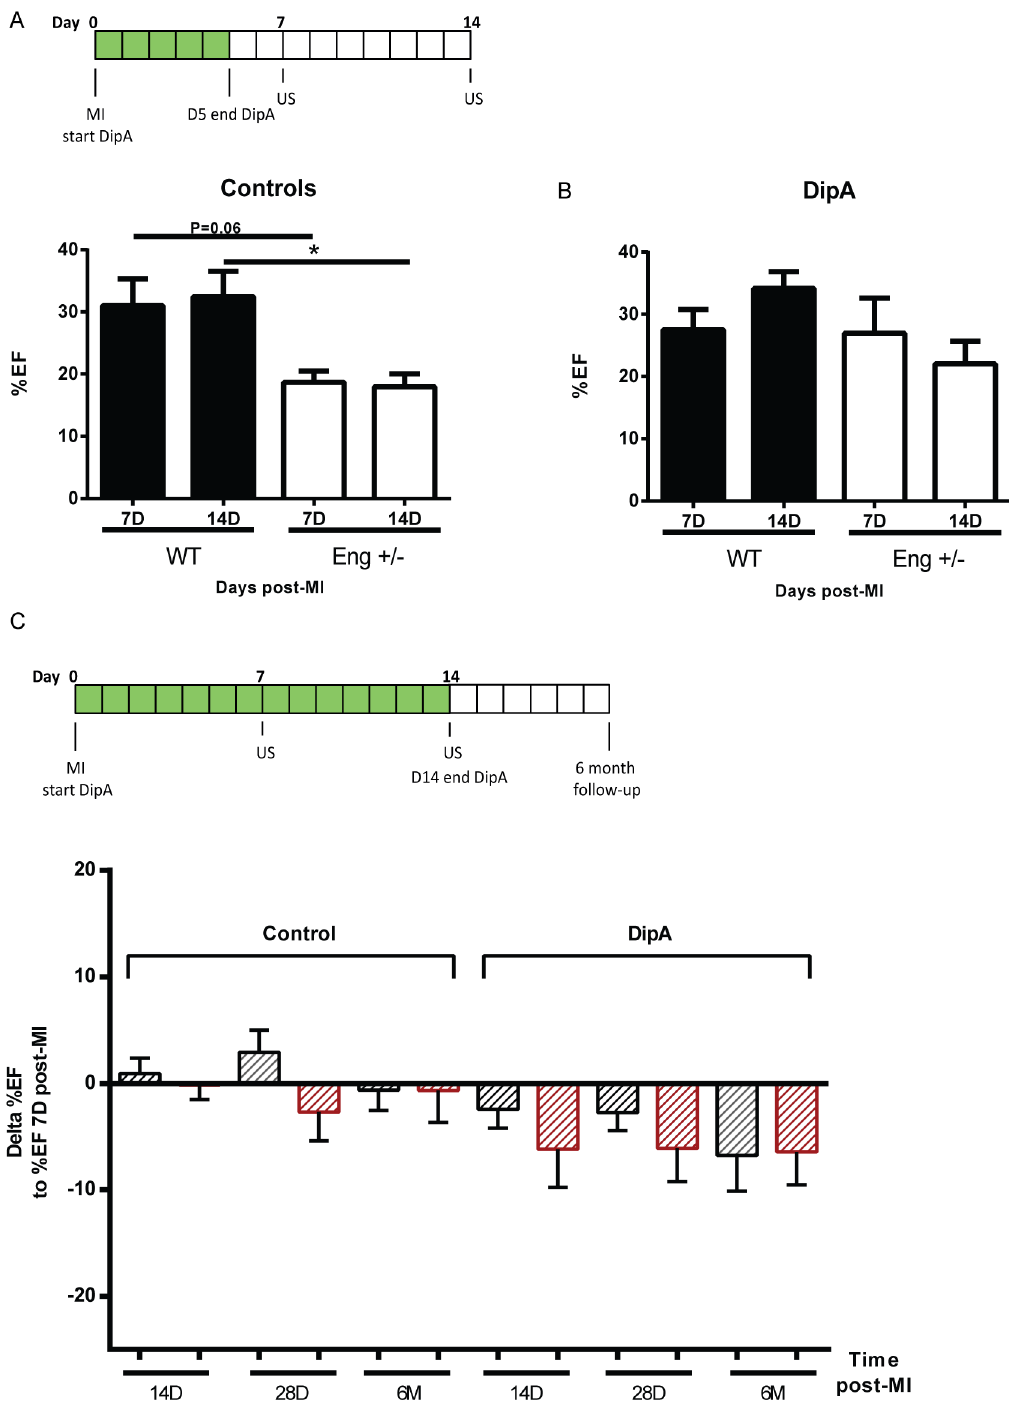
Fig 4. DipA treatment does not maintain improved cardiac function of Eng +/- mice after MI. (A) Experimental overviewand percentage EF at 7 and 14 days post-MI of control treated mice, measuredby ultrasound via left ventricletracing (n = 5–9). Data shown are mean ± SEM, * P < 0.05. (B) PercentageEF 7 and 14 days post-MI of DipA treated mice, measuredby ultrasound via left ventricle tracing. Note that the control WT and Eng +/- groupsare the repeat of measurements used for Fig 1D (n = 9–11). Data shown are mean ± SEM, * P < 0.05. (C) Longterm treatment overviewand Δ %EF. DipA treatment (shown in green) up to 14 days post-MI and cardiac function with extended follow-upof 6 months (n = 5–11). Data depictedas Δ EF are the EF at the time point indicatedon the x-axis